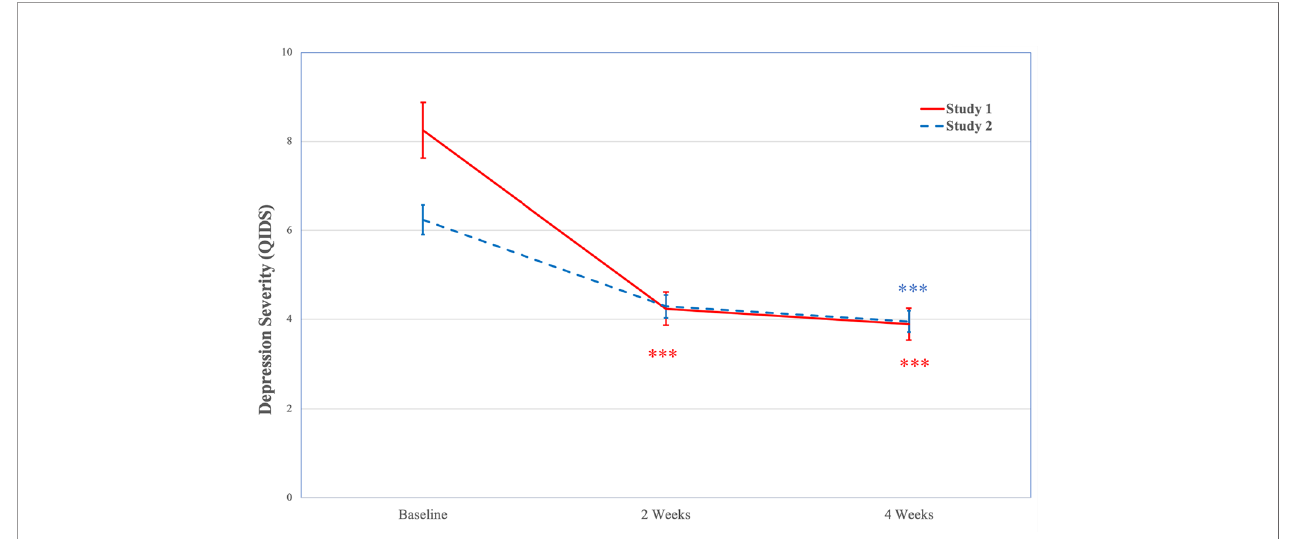
FIGURE 2 | Decreases in Depression Severity (QIDS) Over Time (Study 1 and Study 2). Note. Study 1 N =104; Study 2 N =254; *** p < .001.QIDS, Quick Inventory of Depressive